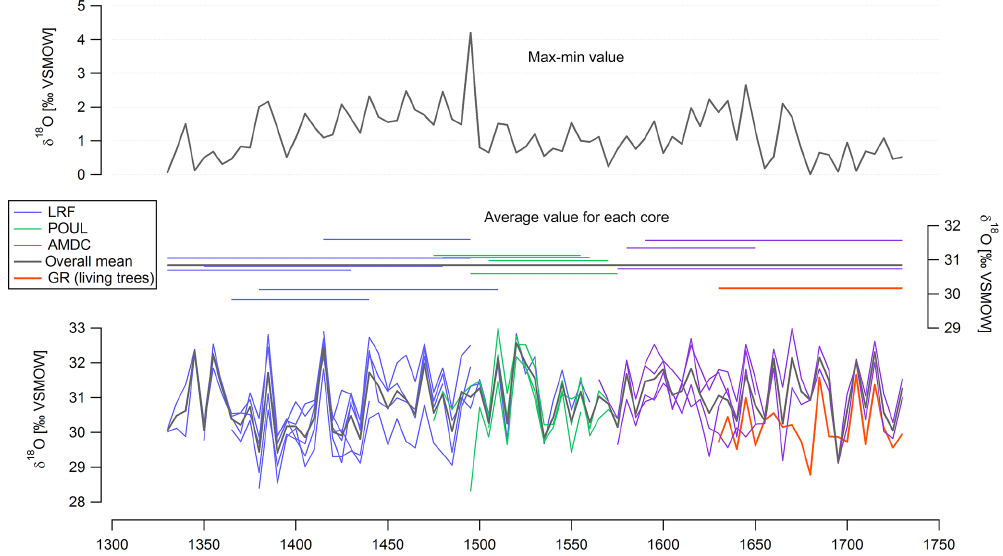
Figure 3. Inter-tree comparison. Bottom: δ 18 O c measured every 5th year for individual timber cores from different buildings in Angoulême (LRF, POUL, and AMDC). The orange line shows the δ 18 O of living trees (GR). Middle: time spans and average δ 18 O values for the respective cores. The thick gray line is the mean δ 18 O of all timber cores over the whole period. Top: range of measured values for each year (maximum minus minimum value).